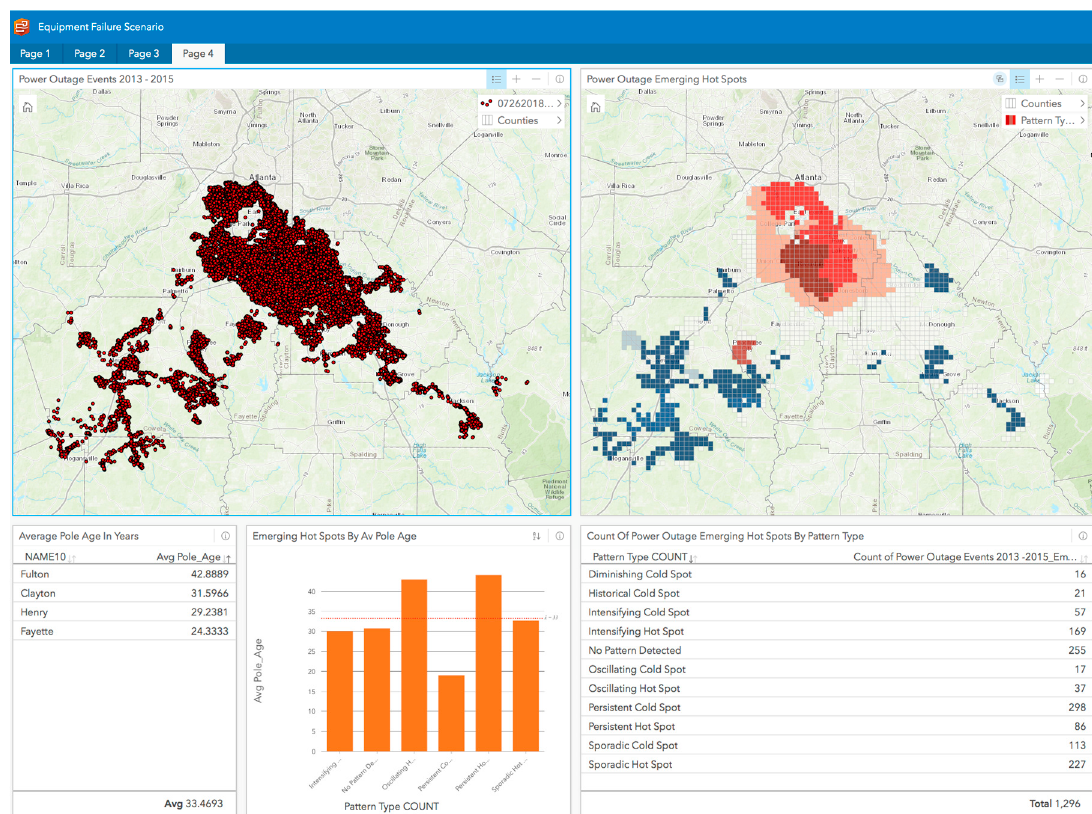
Figure 13. Challenge 3—Equipment Failure Scenario Workbook—Page 4.